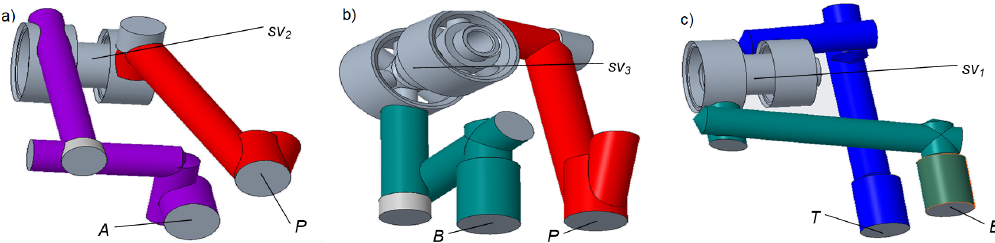
Figure 7. Fluid models of the flow lines: ( a ) P − A , ( b ) P − B , ( c ) B − T ; sv 1 , sv 2 , sv 3 —seat valves.